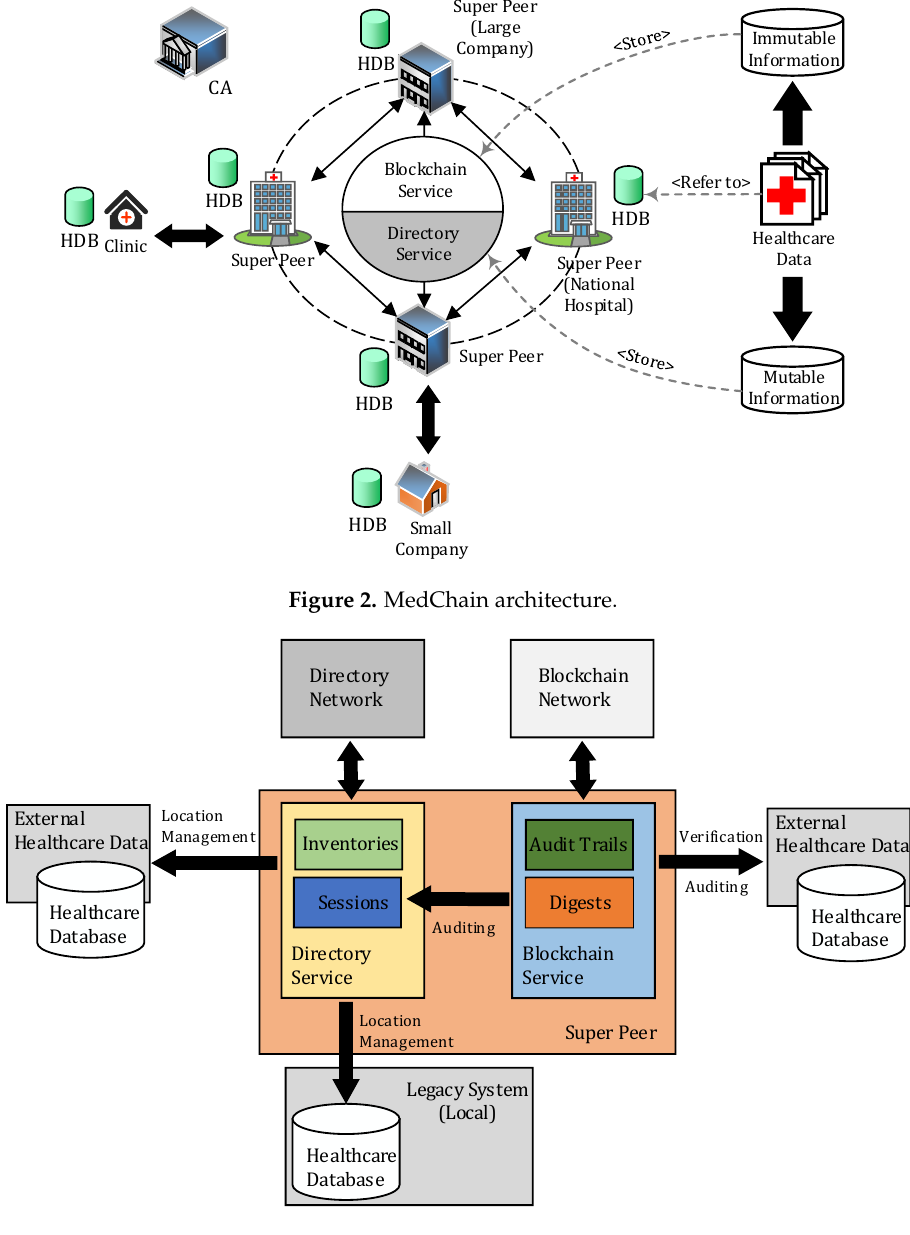
Figure 3. Modules of a super peer.